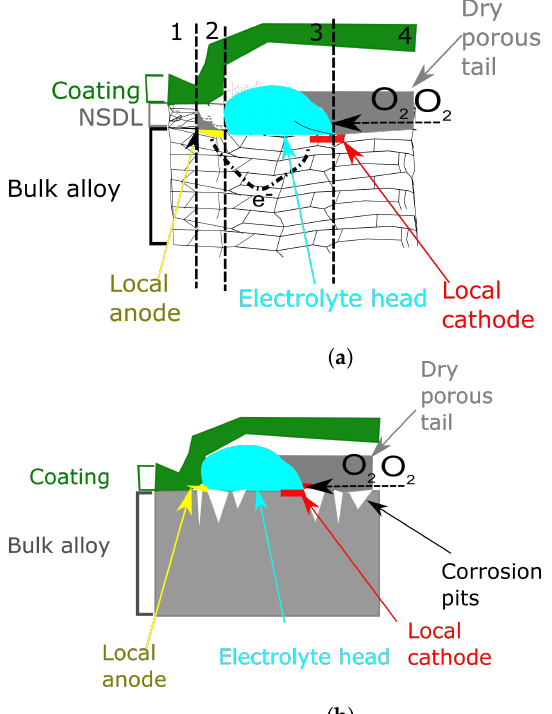
Figure 13. Schematic diagram showing the mechanism of FFC in the presence of NSDL. This schematic was based on the theory illustrated by McMurray et al. Filament propagation ( a ) and successive pitting ( b ). Data from